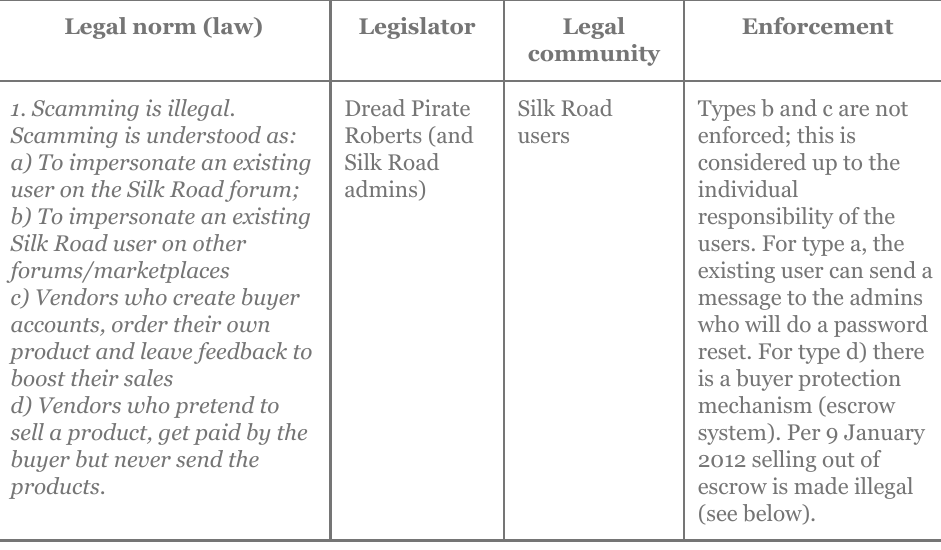
Table 3: Examples of constitutive elements of a legal order present in forum threads Legal norm